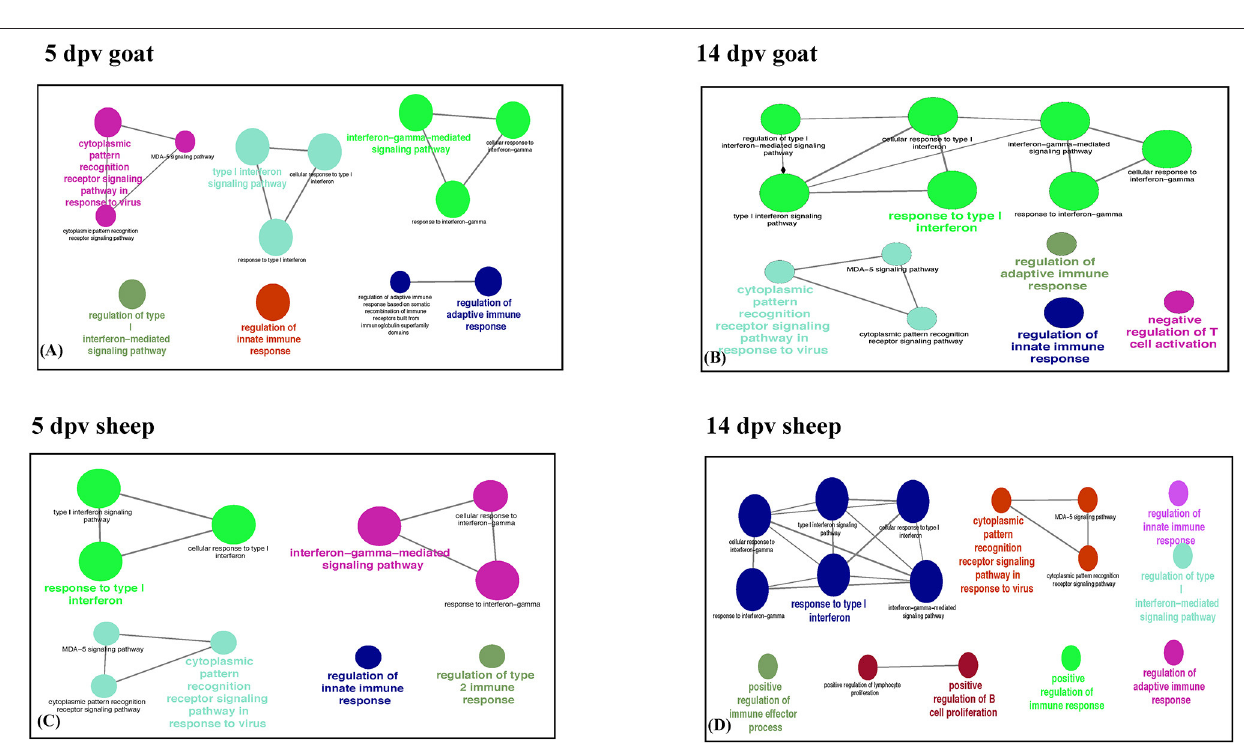
FIGURE 2 | Protein set enrichment analysis using the ClueGO at (A) 5 days post-vaccination (dpv) and (B) 14 dpv vaccinated goats and (C) 5 dpv and (D) 14 dpv vaccinated sheep. The edges of the resulting ClueGO network are based on kappa statistics and reflect the relationships between the GO terms (network nodes) based on the similarity of their associated proteins. The proteins associated with significant GO categories are displayed as well as the p -value associated with the GO term. In the network, only significantly enriched categories ( p -value 0.05, Bonferroni corrected) are shown. The size of the node indicates significance, and the color indicates a